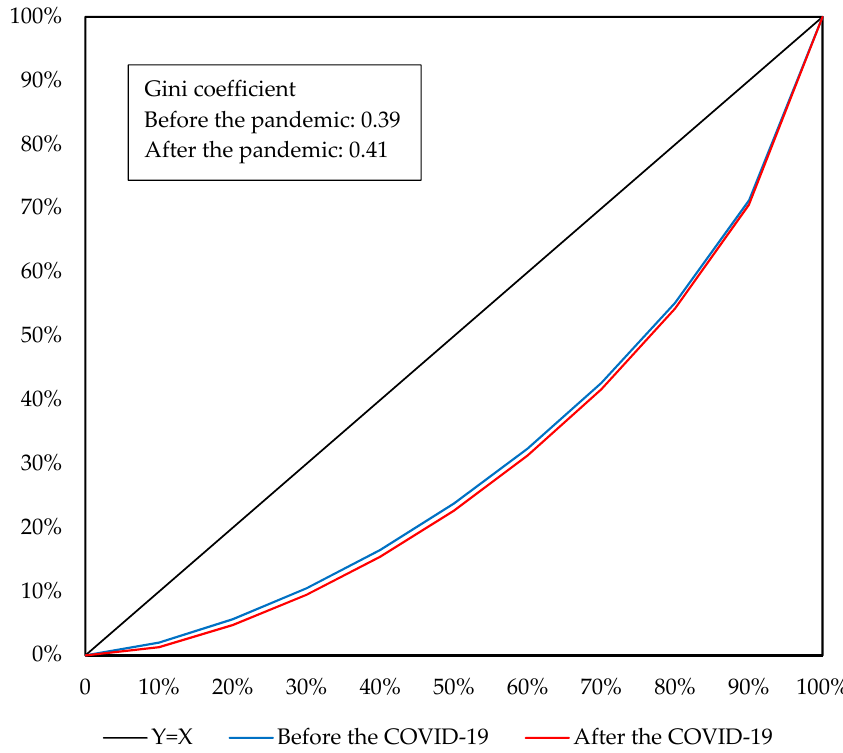
Figure 9. Lorentz curve of rural residents before and after the COVID-19 pandemic. Source: Author’s calculation.